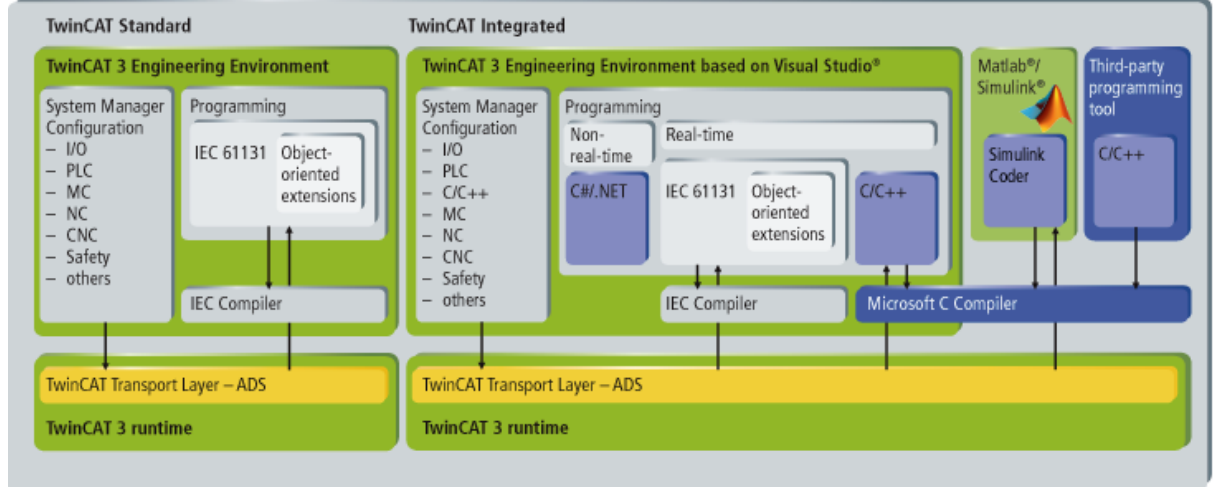
Figure 6: Overview of the TwinCAT 3 XAE capabilities and features (Beckhoff, 2018).